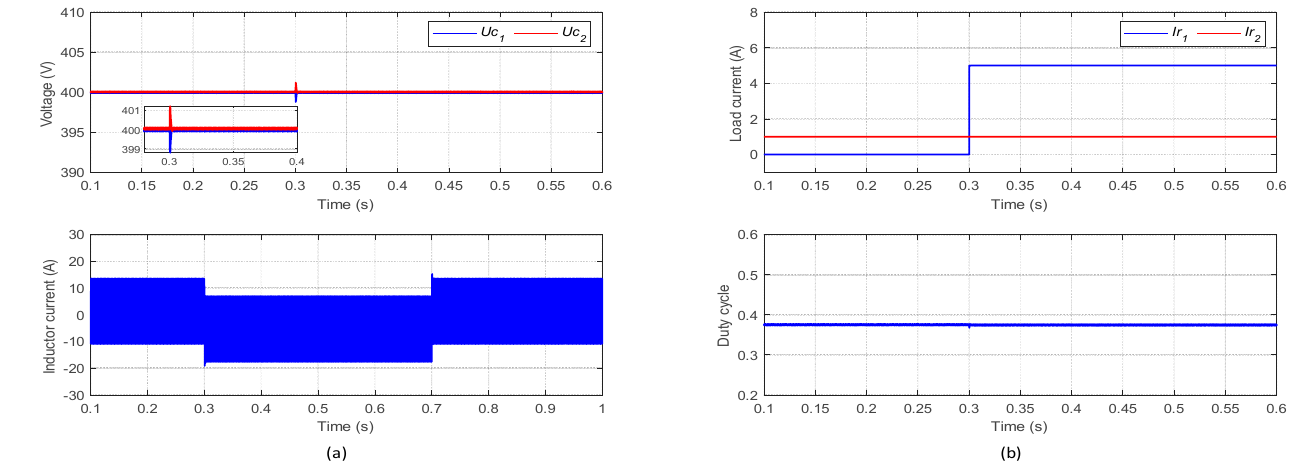
Figure 12. Numerical results with 50% inductance nominal value using the proposed CCS–MPC. ( a ) Inductor current and output voltages. ( b ) Duty cycle and load current.